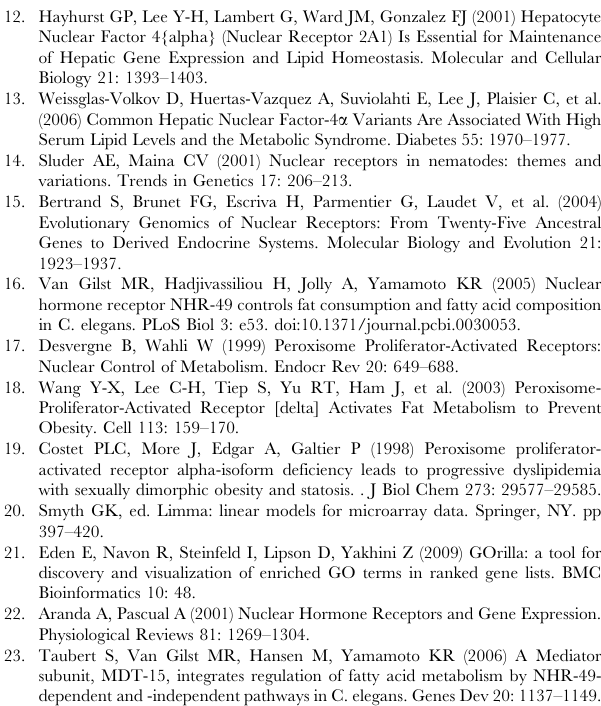
controls. Fold change is indicated in bold where expression levels are up regulated compared to wild-type. Table S2 Summary of yeast-two-hybrid analysis (a) List of candidate NHR-49 interacting proteins identified in yeast two- hybrid screens using NHR-49-LBD (this study) or full-length NHR-49 [24] as bait, (b) Binding strengths of ‘‘preys’’ to the Table S3 List of forward primers used for qRT-PCR. Table S4 List of reverse primers used for qRT-PCR. Table S5 List of differentially expressed genes in nhr-66 compared to wild-type animals using microarray analysis. The data represent the analysis from three independent mRNA isolations and microarray hybridizations. ‘‘ID’’ refers to the identity of individual spots on the arrays, ‘‘logFC’’ represents the log of the fold change, ‘‘AveExpr’’ represents the averaged spot intensity. Table S6 Occurrence of gene families in microarray results for NHR-66, based on GO terms. Table S7 List of differentially expressed genes in nhr-80 compared to wild-type animals using microarray analysis. The data represent the analysis from four independent mRNA isolations and micro- array hybridizations. ‘‘ID’’ refers to the identity of individual spots on the arrays, ‘‘logFC’’ represents the log of the fold change, ‘‘AveExpr’’ represents the averaged spot intensity.